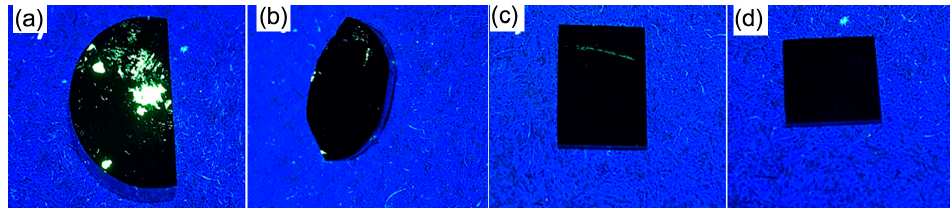
Figure 1. NDT analysis of melted FeMnSiAl alloy for the C sample: ( a ) first melt; ( b ) after five re-melts; and for the HR sample: ( c ) first melt; ( d ) after five re-melts. The XRD method (performed on an Expert PRO-MPD system, Panalytical, Almelo, Copper-X-ray tube (K α -1.54°)) was used to identify the formed phases in the experimental FeMnSiAl alloy, at 25 °C (room temperature), and DSC to study the solid-state transfor- mation. The samples were prepared for the DSC test, for which very small pieces of each sample (C and HR), of up to a 50 mg mass, were required. The equipment used was NE- TZSCH DSC 200 F3 Maya, with a protective atmosphere of Ar. The temperature program at